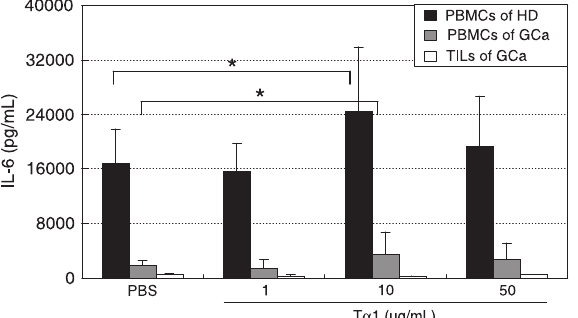
Figure 3. Effect of Tα1 on IL-6 cytokine secretion in PBMCs from healthy donors (HD) and gastric cancer patients (GCa), and in TILs from gastric cancer patients. PBMCs and TILs were cultured with PBS or 1, 10, or 50 µg/mL Tα1 for 72 h. The levels of Th2 cytokines were determined using the Bio-Plex cytokine assay. PBMCs = peripheral blood mononuclear cells; TILs = tumor- infiltrating lymphocytes. Data are reported as means ± SD for 3 separate experiments (P < 0.05, t -test).